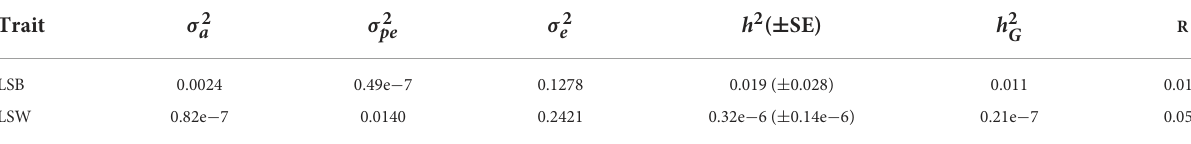
TABLE 4 Estimation of variance components and genetic parameters for litter size at birth (LSB) and litter size at weaning (LSW) in the Markhoz goats. Trait